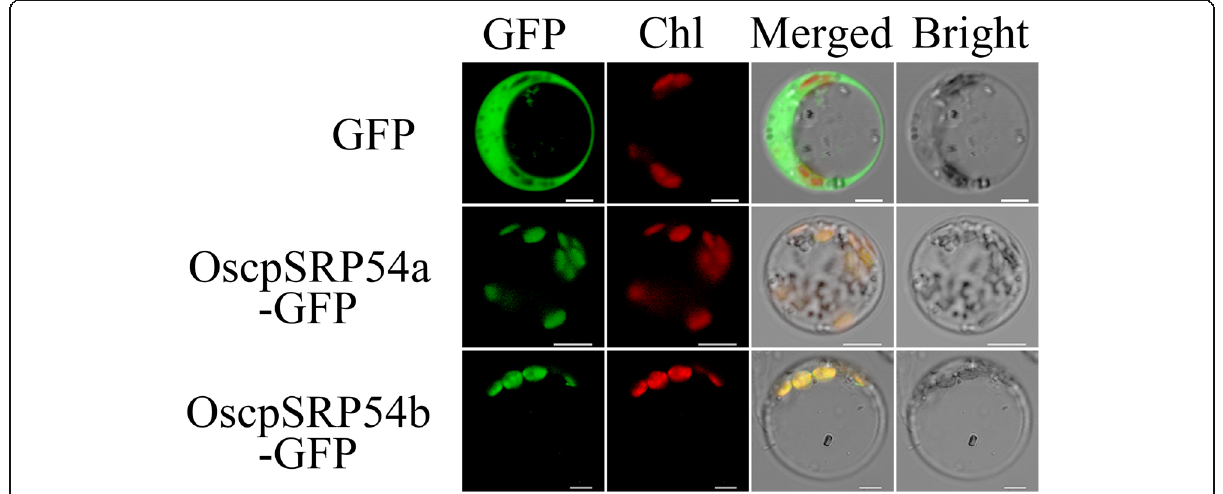
Fig. 7 Subcellular localization of OscpSRP54a and OscpSRP54b in rice protoplasts. Green fluorescence indicates GFP signal, red fluorescence indicates chloroplast autofluorescence, and yellow fluorescence indicates the merged signal of green and red